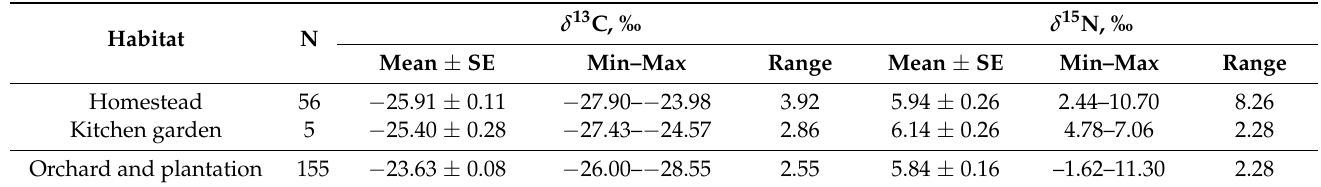
Table 4. Central position (mean ± SE) and ranges of stable isotope ratios in the hair of C glareolus , living synoptically in the investigated habitats, according to